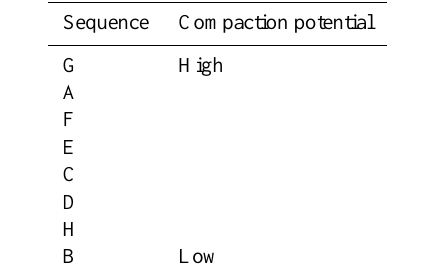
Table 1. Relative potential of key sequences for peat compaction, based on lithological composition. For the lithological built-up of the sequences see Fig.